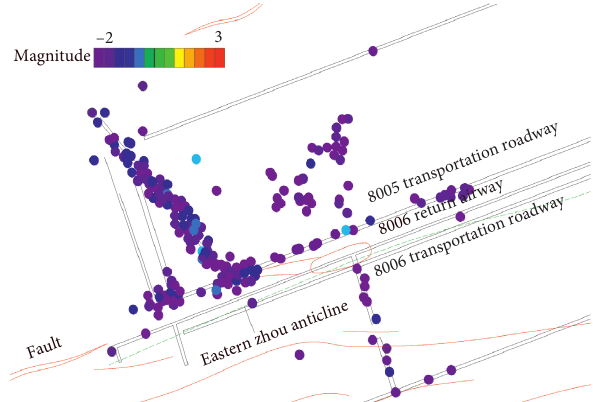
Figure 3: Distribution plan of microseismic events induced by roadway tunneling.